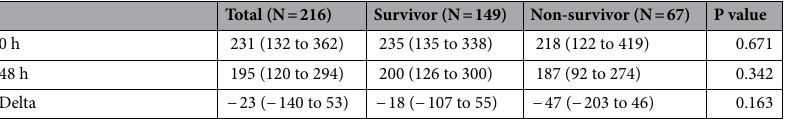
Table 2. Comparison between hospital survivors and non-survivors. Delta is defined by the difference between the 0 h and 48 h data (48 h minus 0 h). COPD chronic obstructive pulmonary disease, CKD/ESRF chronic kidney disease/end-stage renal failure, APACHE IV Acute Physiology and Chronic Health Evaluation IV, WCC the white cell count, NLR the neutrophil-to-lymphocyte ratio, MLR the monocyte-lymphocyte ratio, RDW the red cell distribution width, PLR the platelet-to-lymphocyte ratio.